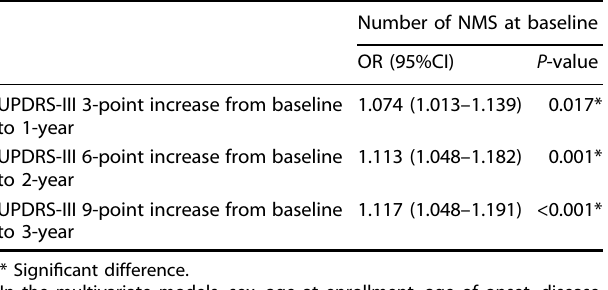
Table 3. Association between baseline NMS number and motor progression in